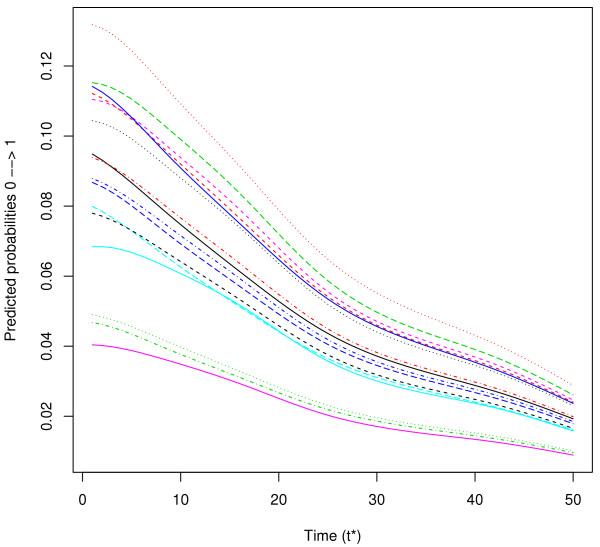
Predicted probabilities (see formula (7)) of a patient in state 0 developing VAP betweent∗andt∗ + 3days for a patient from the 16 different centers. Predictions given for a men, aged > 62, SAPSII<33, with medicine admission, no chronic diseases, no diabetes, no ARDS, no Trauma, with shock, no acute respiratory failure, no antimicrobials, with inotropes, with enteral and parenteral nutrition.